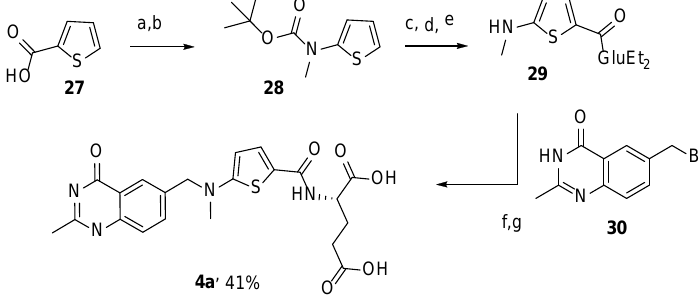
Scheme 15. Multistep synthesis of Raltitrexed 4a starting from thiophene-2-carboxylic acid 27